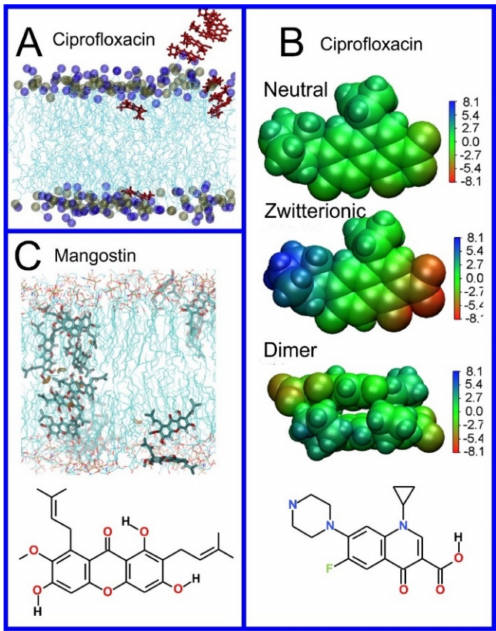
Figure 11. ( A ) Snapshots of MD simulation showing a stack of neutral ciprofloxacin entering the lipid bilayer. ( B ) Electrostatic potential maps at the molecular van der Waals surface in a dielectric continuum corresponding to the water phase calculated using the DFT method and chemical structure of ciprofloxacin. ( C ) Snapshots of MD simulation showing transmembrane arrangement of mangostin molecules and its chemical structure. A and B reproduced with permission from ref. [233]; C reproduced with permission from ref.